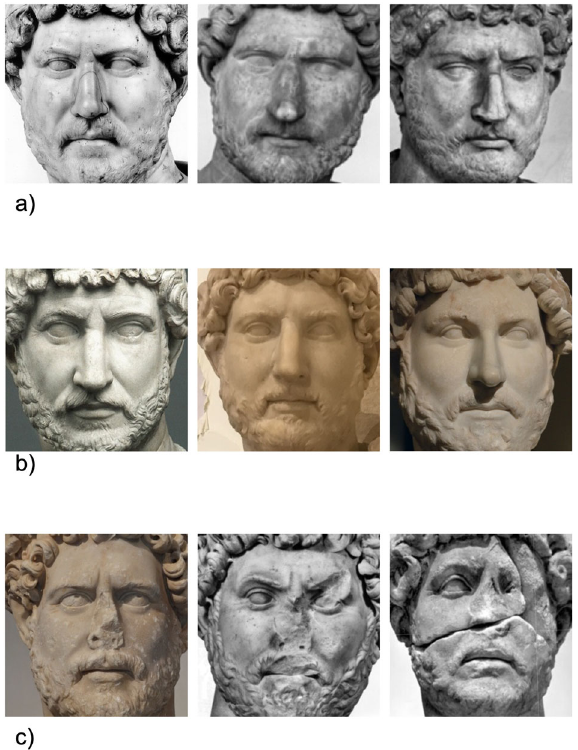
Fig. 2 Images of Emperor Hadrian in the dataset. a Varying poses. b Varying lighting conditions. c Damages in the face areas. Images A1 – A3, B1 and C2 – C3 by the Arachne object database (licensed under CC license BY-NC-ND 3.0), B2 and C1 by Carole Raddato (licensed under CC BY-NC- SA 2.0), and B3 authors ’